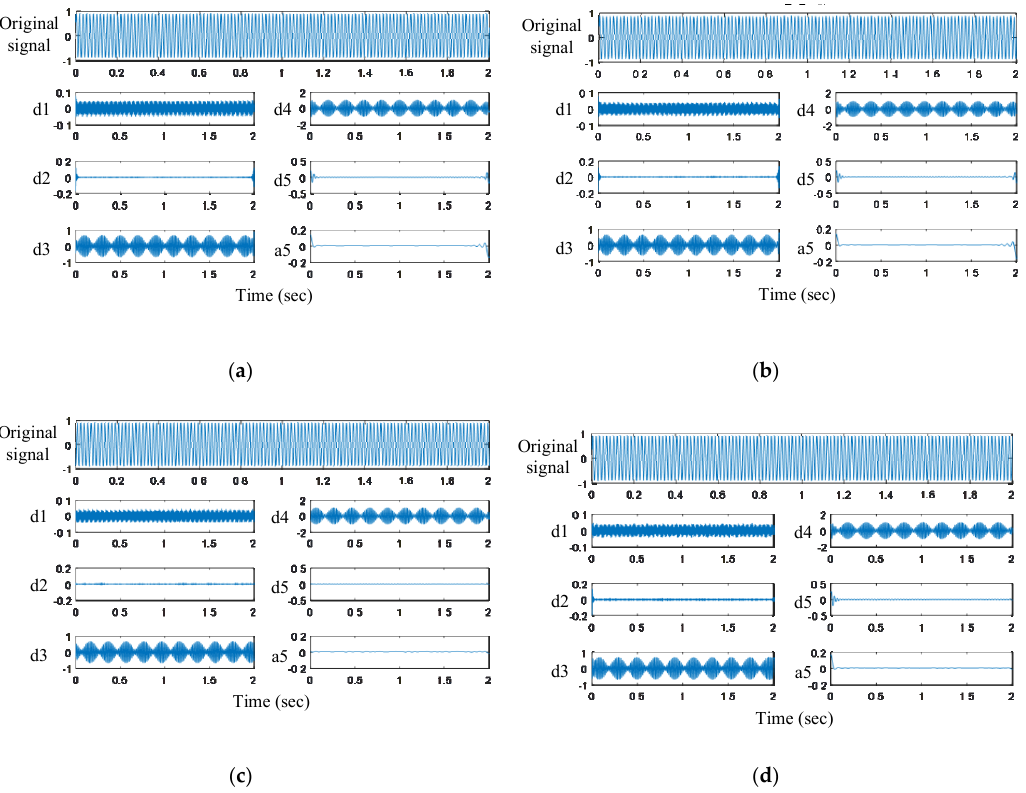
Figure 13. ( a ) MRA of normal motor; ( b ) MRA of bearing failure; ( c ) MRA of stator winding failure; ( d ) MRA of rotor